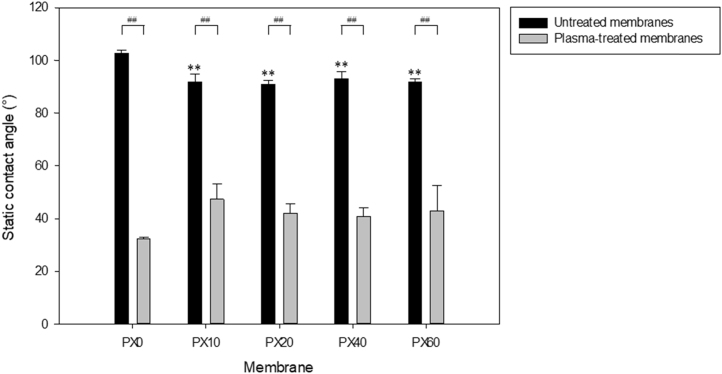
Contact angle of membranes with and without oxygen plasma treatment. Data shown represents mean ± SD (n = 3–14). ** indicates significance with respect to PX0 (p < 0.001); ## indicates p < 0.001 for the indicated values.